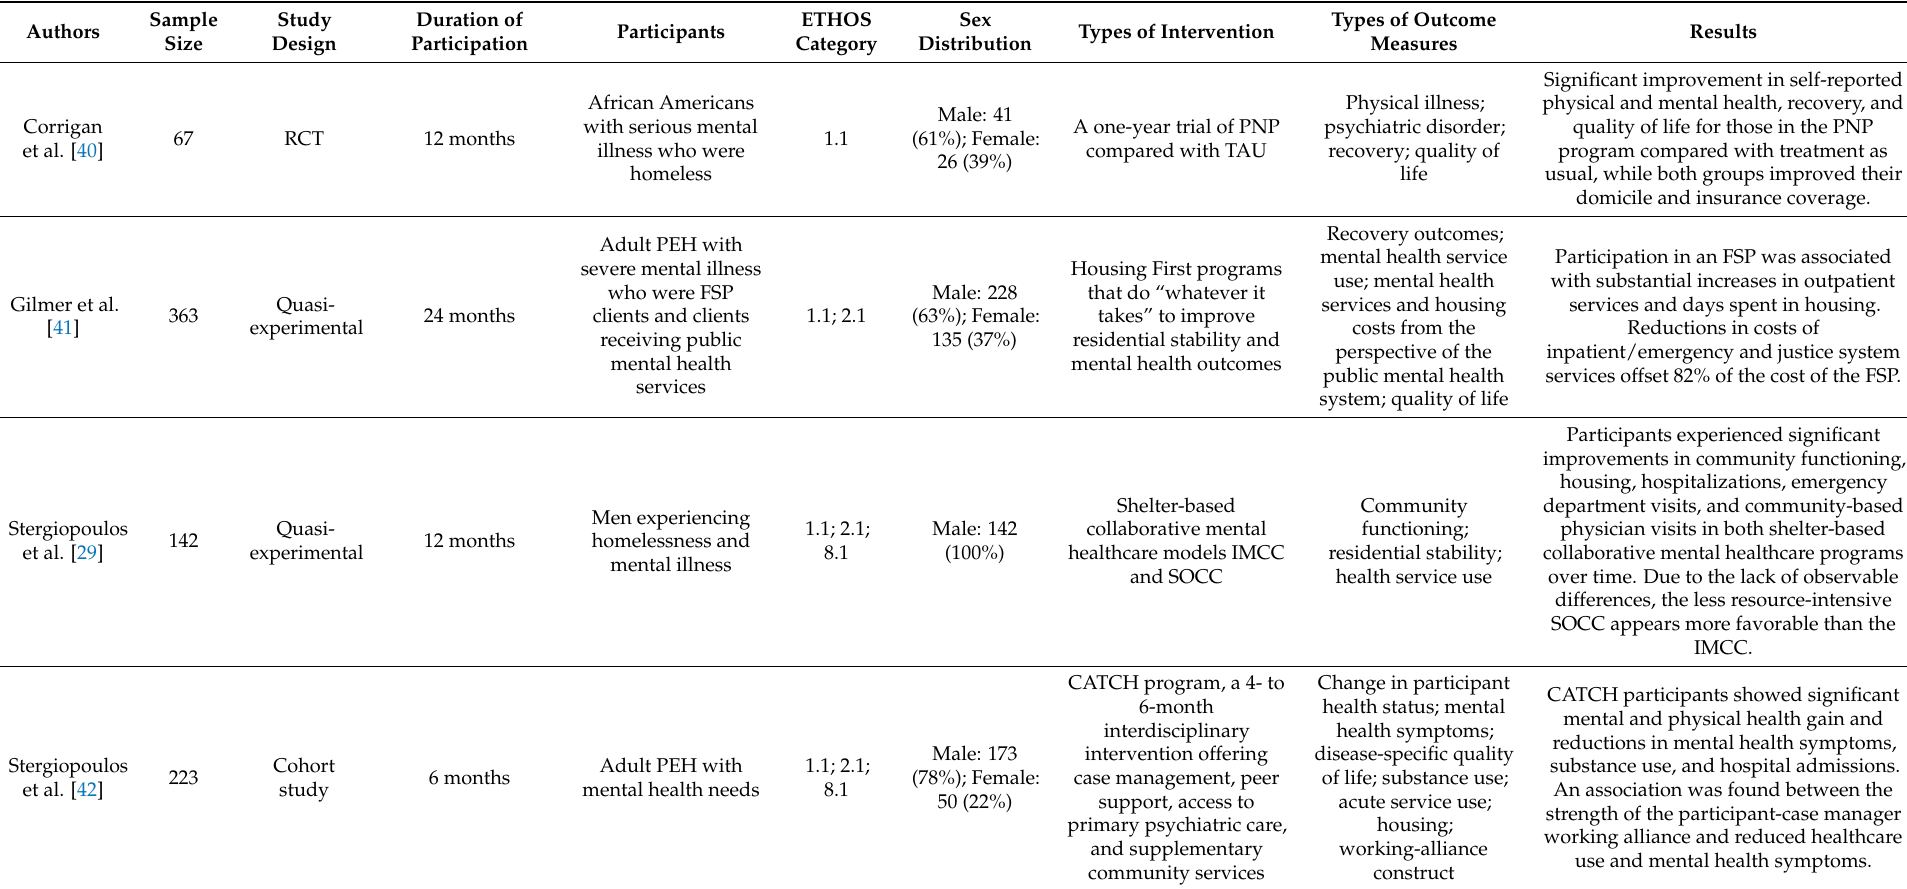
Table 1. Methodological information of included